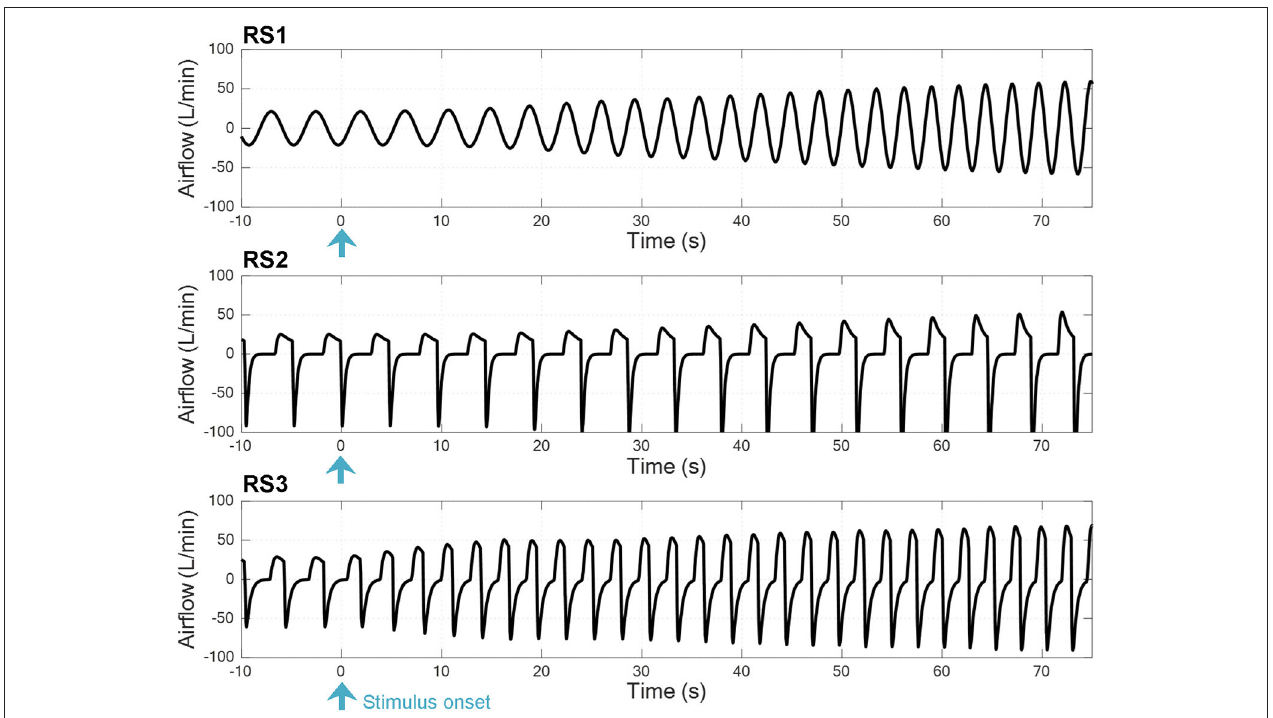
FIGURE 3 | Time series breath-to-breath of airflow signal at the onset of exercise when a step input was used to simulate the respiratory system models RS1, RS2, and RS3 (see